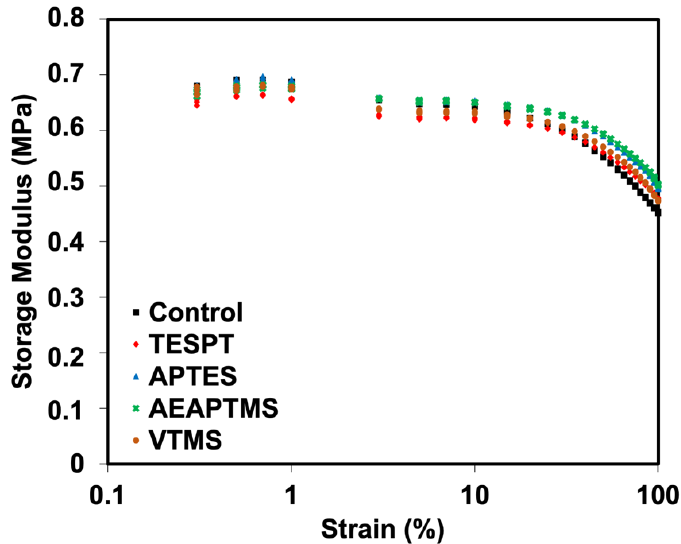
Figure 3. Storage modulus ( G (cid:48) ) as a function of strains of NR/HNT composites filled with and without silane coupling